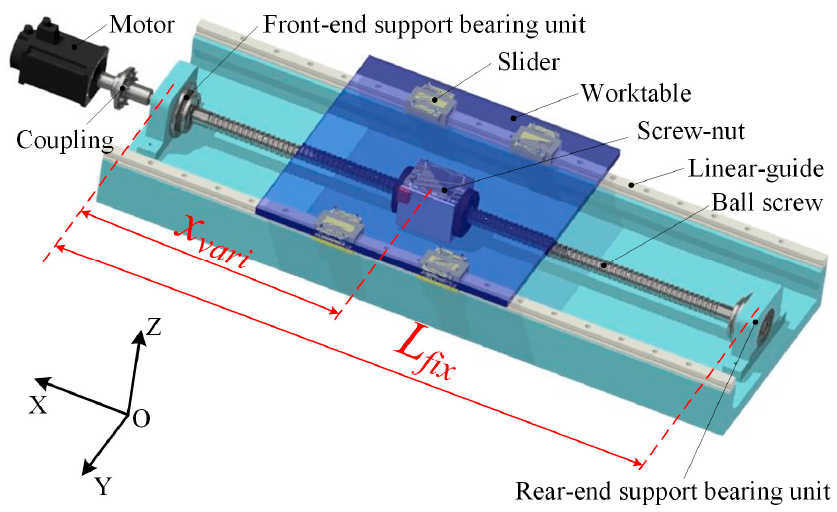
Figure 1. Schematic structural diagram of a ball screw feed system.